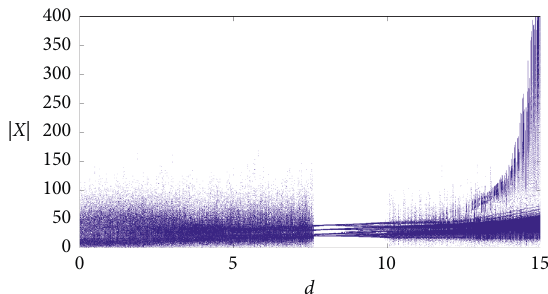
Figure 2: Bifurcation diagram for increasing parameter d